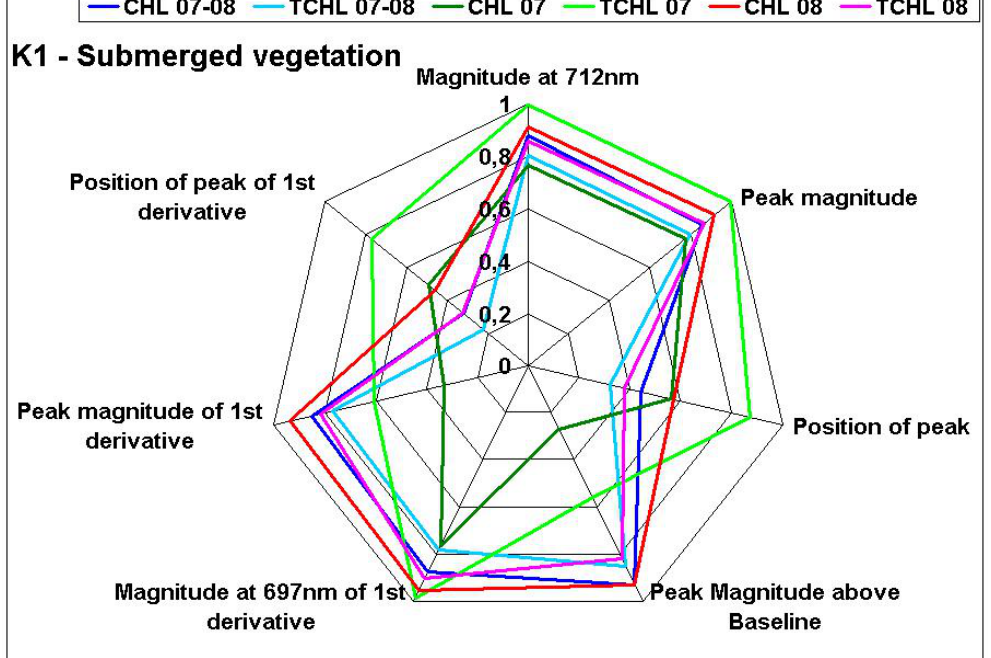
Figure 5. Radar diagrams of the correlation coefficients calculated for biomass concentrations’ estimation using various algorithms for kettle holes K1, K4 and K5 (n = 15 of